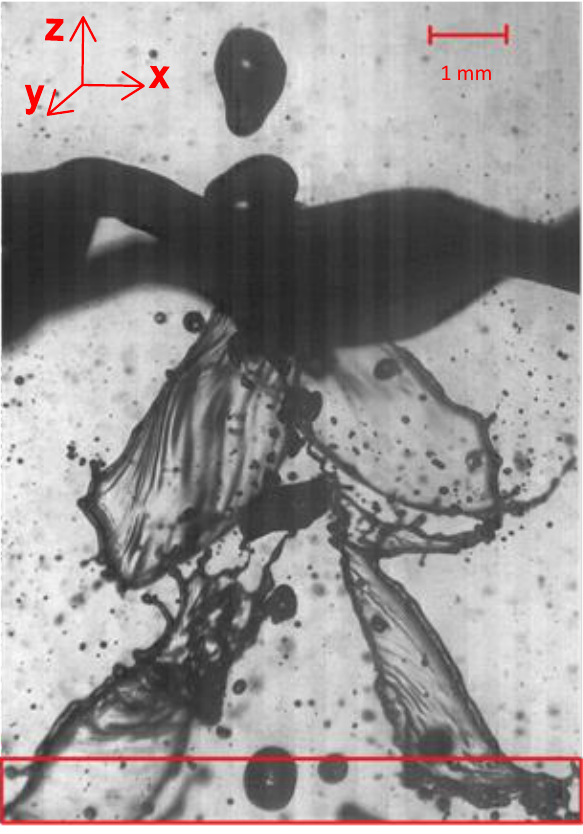
Fig. 6. The liquid dispersion on the crossing of two wires, 𝑊𝑒_𝑑 = 2217 and zero velocity of the air